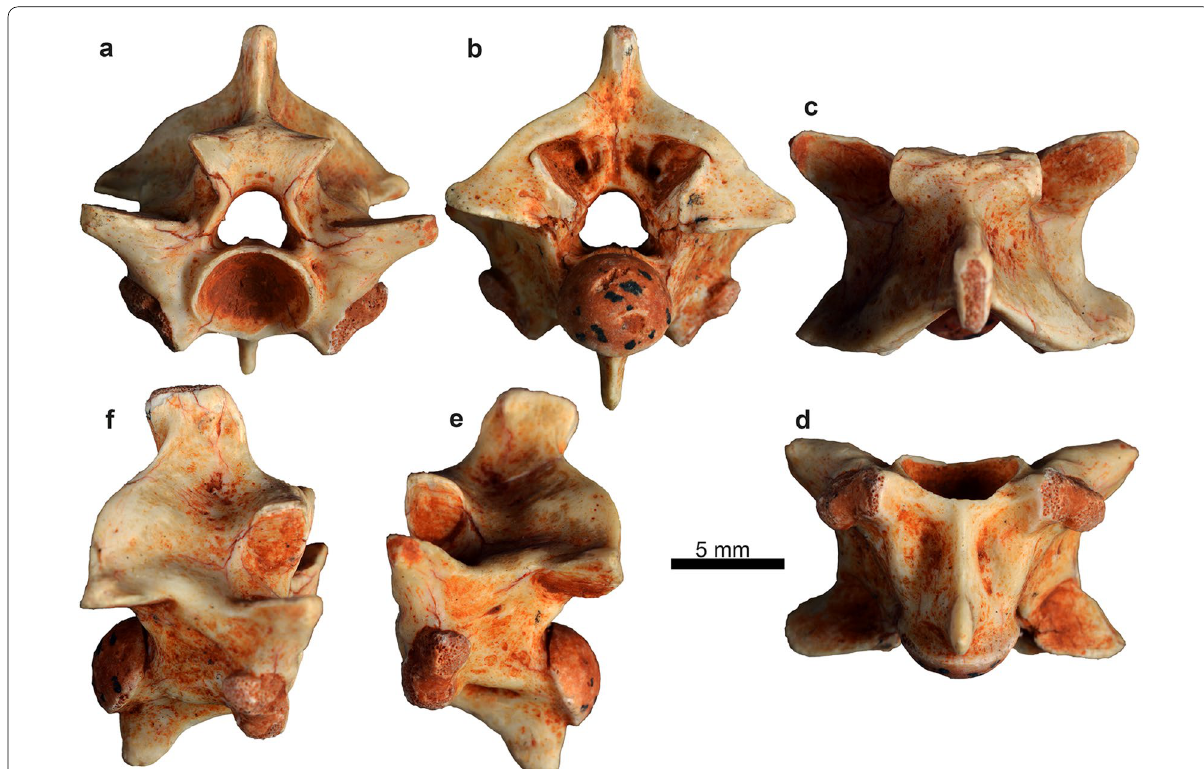
Fig. 78 Phosphoroboa filholii comb. nov. from an imprecisely known locality in the Phosphorites du Quercy: anterior trunk vertebra (NHMW 2019/0033/0001) in anterior ( a ), posterior ( b ), dorsal ( c ), ventral ( d ), left lateral ( e ), and right lateral ( f )